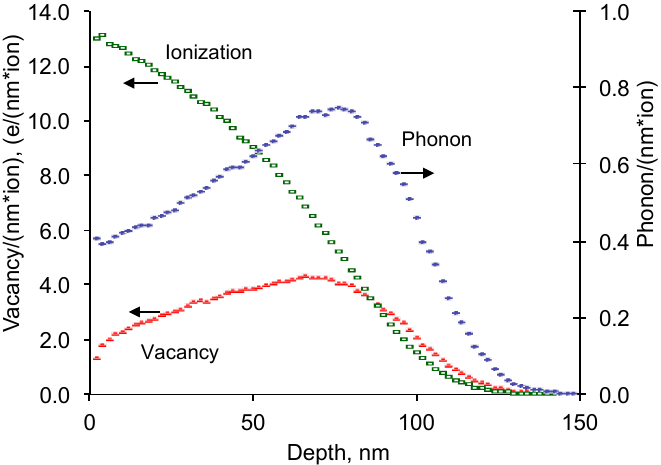
Figure 1. Ionization, phonon and total vacancy profiles after nitrogen ion of 20 keV energy penetrating into EPDM rubber. By SRIM calculations.